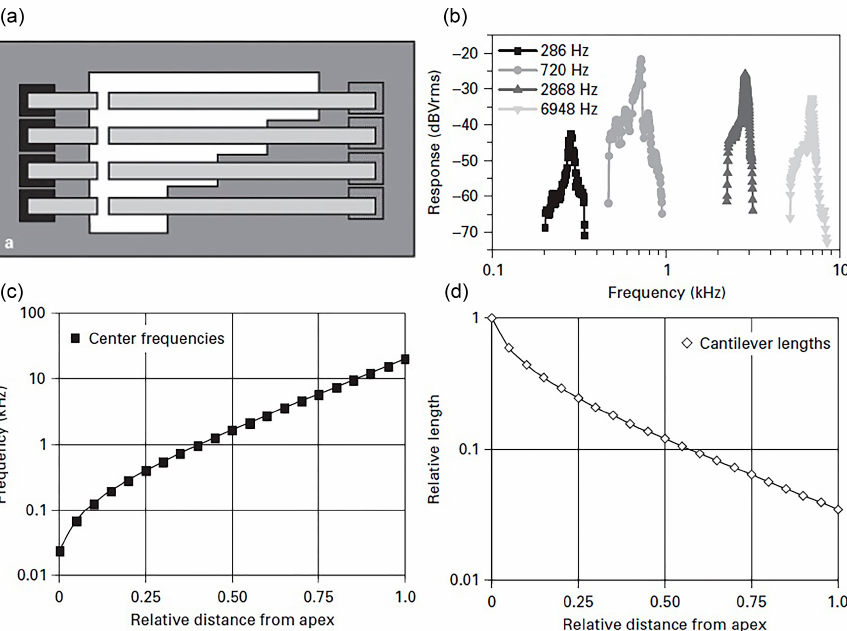
Figure 15. ( a ) 4-channel multiresonant microphone made of four free-standing cantilevers with different lengths. There is a 20 µm air gap between the cantilevers and the receiving light pipes. ( b ) The measured frequency response from the cantilevers at 70 dB SPL. ( c ) The tonotopic mapping characteristics of a human cochlea demonstrating the frequency point as a function of distance from apex of cochlea. ( d ) The corresponding length of a cantilever that can give the required resonant frequency f c at the frequency points [75]. Reprinted by permission from S. Karger AG, Basel. The cantilever vibration is seen as the variation of light intensity by the